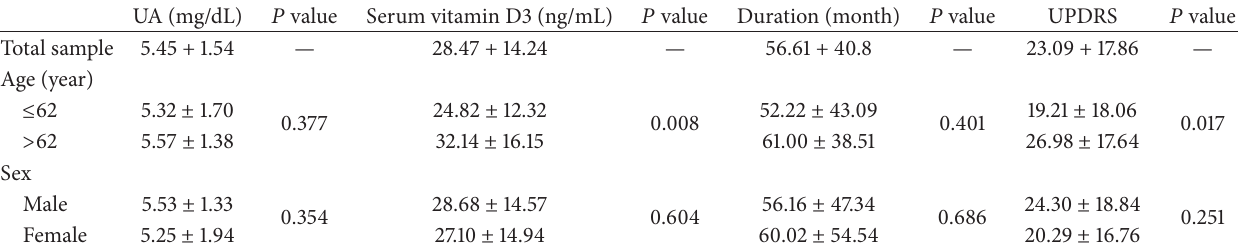
Table 1: The mean values of uric acid level, vitamin D3 level, and UPDRS score in total study sample and in different age and sex groups. UA (mg/dL)